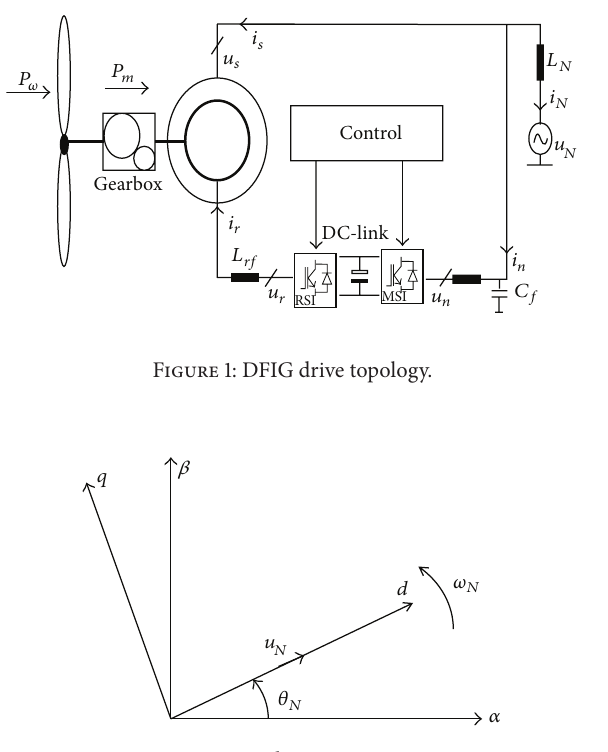
Figure 2: Voltage